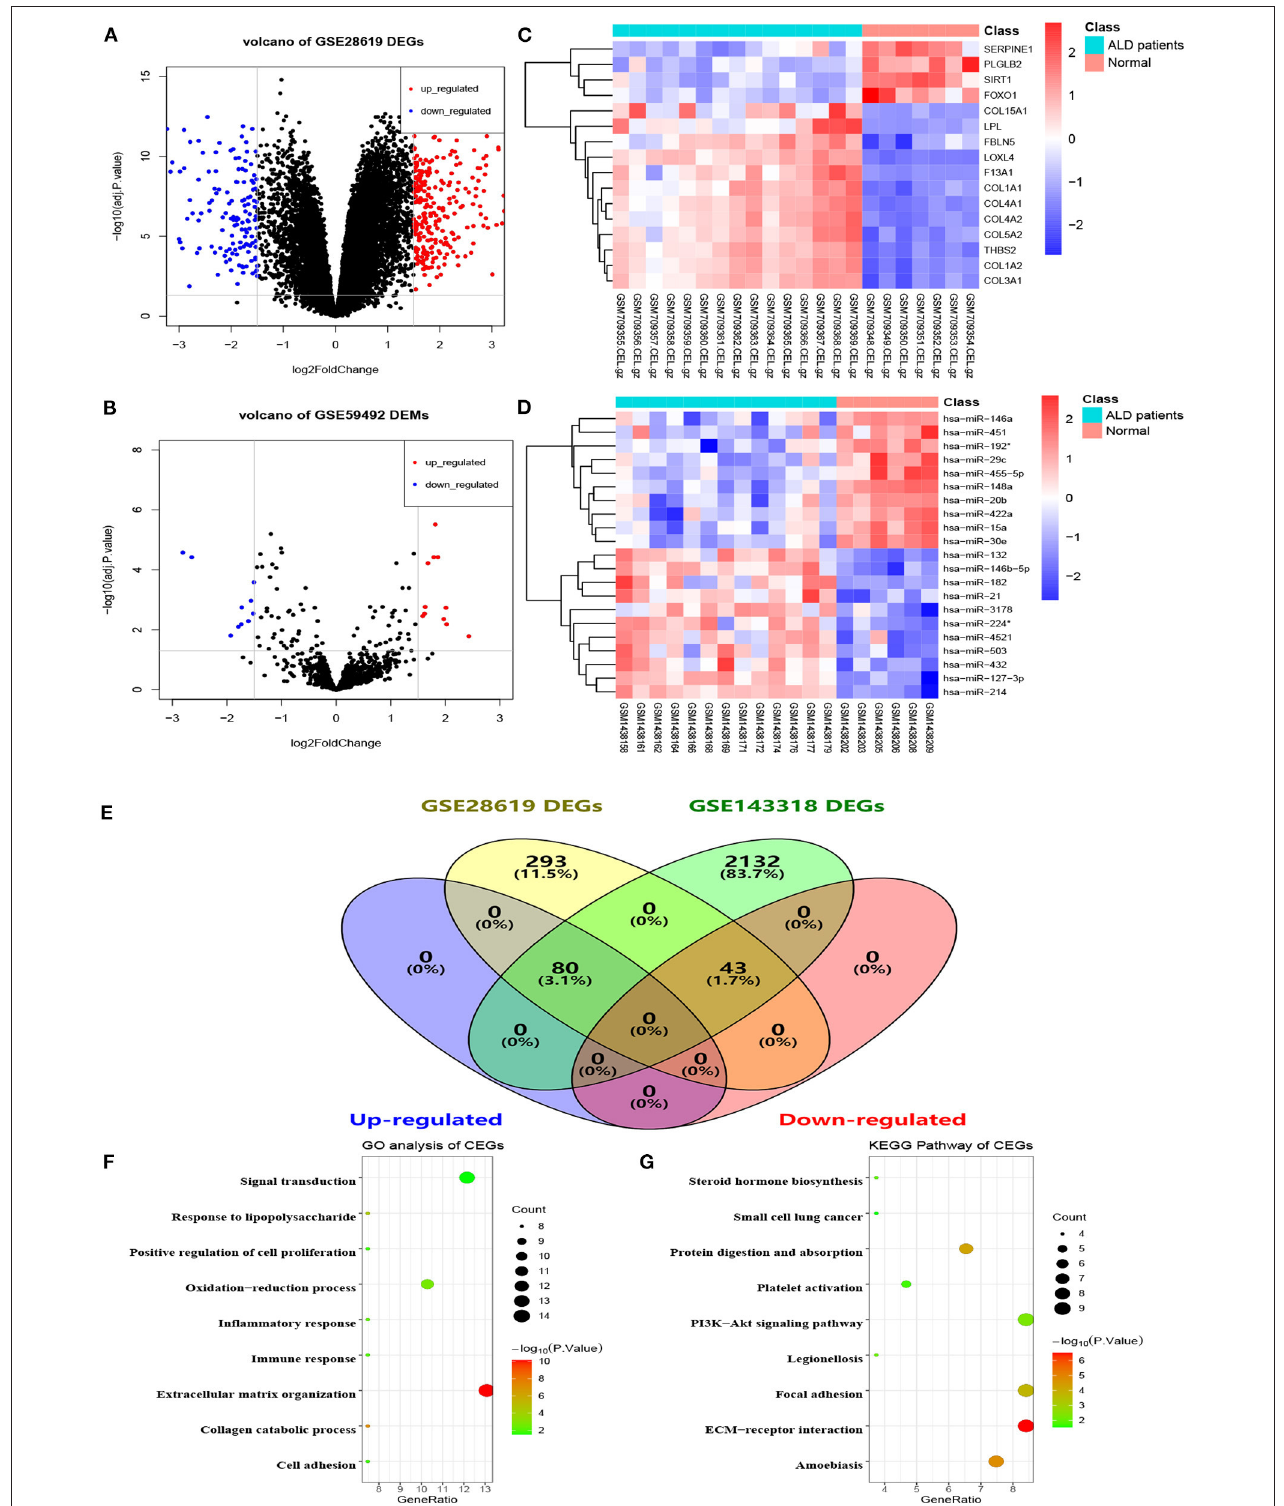
FIGURE 2 | Identification of differentially expressed genes and miRNAs between patients with alcoholic liver disease and healthy controls. (A) Volcano plot of DEGs in GSE28619, (B) volcano plot of DEMs in GSE59492, (C,D) heatmaps of partial DEGs and DEMs, (E) common DEGs between GSE28619 and GSE143318, (F) GO enrichment analysis of CEGs, (G) KEGG pathway analysis of CEGs. DEGs, differentially expressed genes; DEMs, differentially expressed miRNAs; ALD, alcoholic liver disease; CEGs, common differentially expressed genes; GO, gene ontology; KEGG, kyoto encyclopedia of genes and genomes.